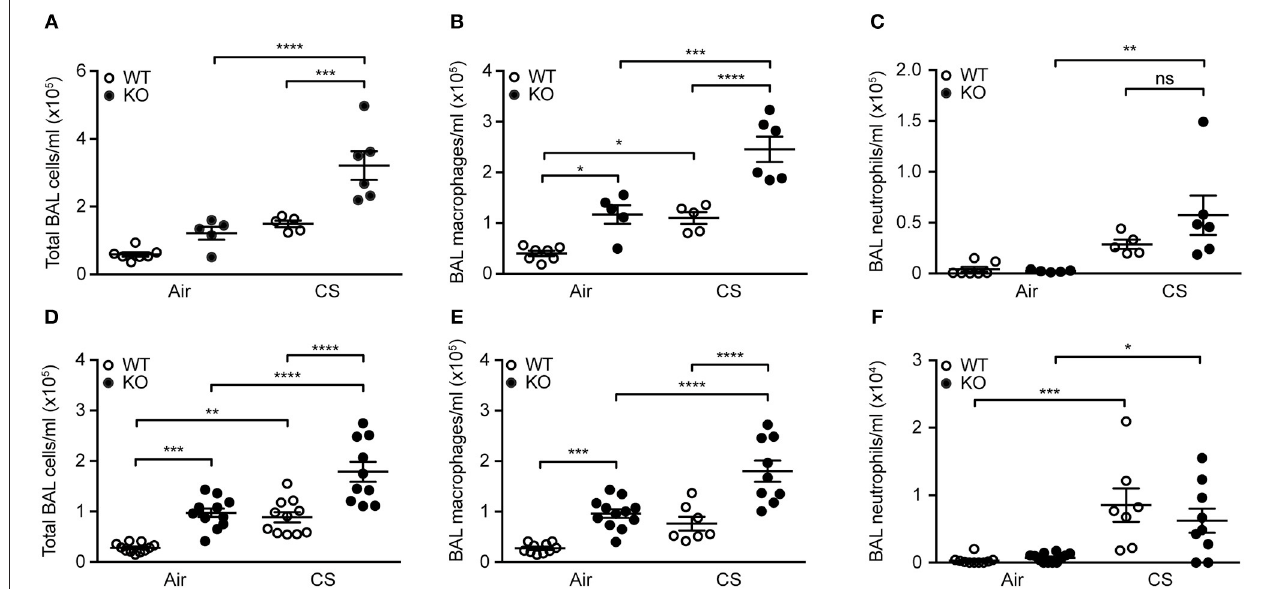
FIGURE 3 | SP-D deficiency aggravates cigarette smoke (CS)-induced airway inflammation in mice. SP-D-deficient mice exhibit higher total cell count and macrophage number in bronchoalveolar lavage fluid (BAL) compared to WT littermates both after (A,B) 12 weeks and (D,E) 3 days of CS exposure, while the increase in neutrophil numbers induced by (C) 12 weeks, or (F) 3 days of CS exposure is not influenced by SP-D deficiency. n = 5–7 (A–C) , 7–12 (D–F) . * p < 0.05, ** p < 0.01,*** p < 0.001, **** p < 0.0001, analyzed by one-way ANOVA followed by Bonferroni’s test. ns, not